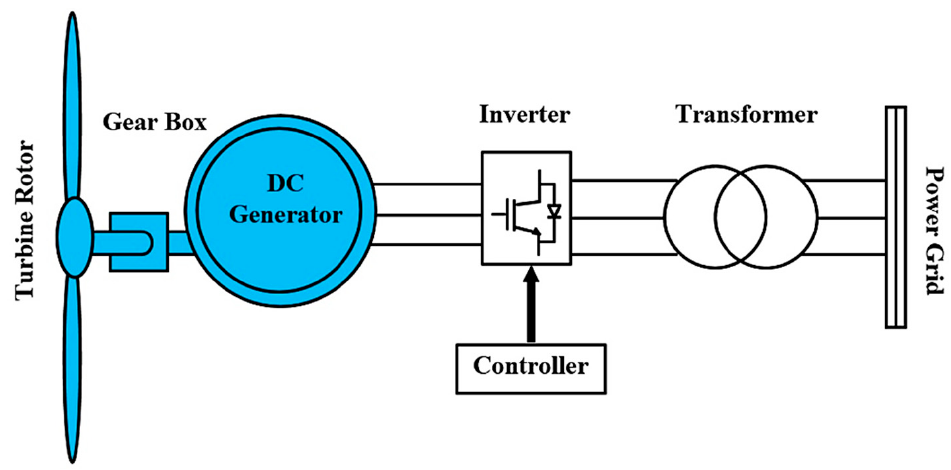
Figure 2 . DC generator layout for wind energy systems [34]. Figure 2. DC generator layout for wind energy systems